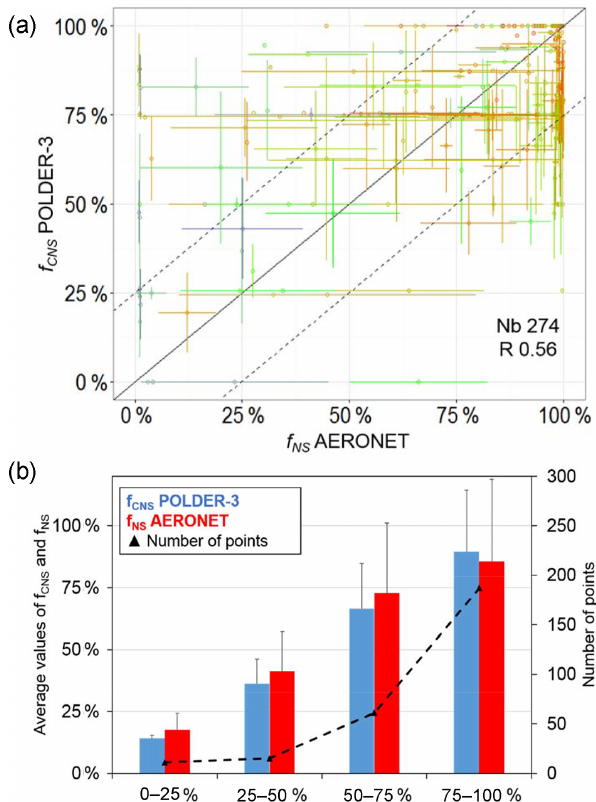
Figure 9. (a) Scatter plot of the fraction of coarse mode optical depth due to non-spherical particles ( f CNS ) retrieved by POLDER- 3 and that of total optical depth ( f NS ) estimated by AERONET. Values are expressed in percent. As the AERONET f NS depends on the total aerosol optical depth, only data points for which the mea- sured AOD exceeded 0.10 and the AOD C represented more than 30% of the total AOD are represented. The solid line is the bisec- tor. Dashed lines represent the interval of ± 25% of agreement be- tween POLDER-3 f CNS and AERONET f NS . (b) Mean and stan- dard deviations of coarse mode optical depth due to non-spherical particles measured by POLDER-3 ( f CNS , blue) and that of total optical depth estimated by AERONET ( f NS , red) are classified into four classes: spherical ( f CNS ≤ 25%); predominant spher- ical (25% < f CNS ≤ 50%); predominant non-spherical (50% < f CNS ≤ 75%); non-spherical (75% < f CNS ≤ 100%). Values are expressed in percentages. Only AERONET data points for which the AOD > 0 . 10 and AOD C / AOD > 0 . 30 are represented. The black triangles represent the number of points in each class (the dashed curve is represented for increased readability).